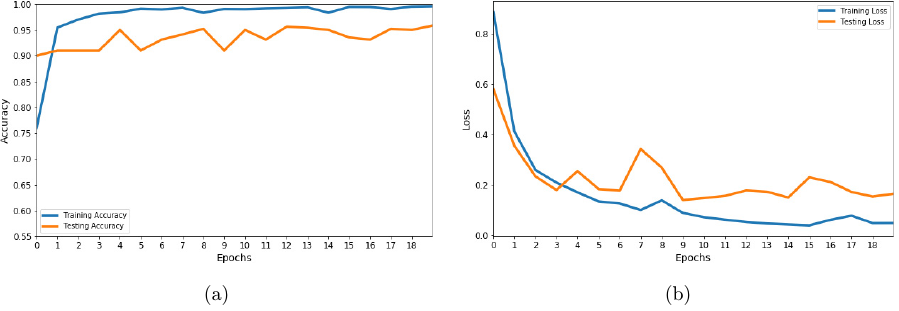
Fig. 16. Graph of the ResNet50 þ spatial transformer model: (a) Epochs vs. Accuracy (b) Epochs